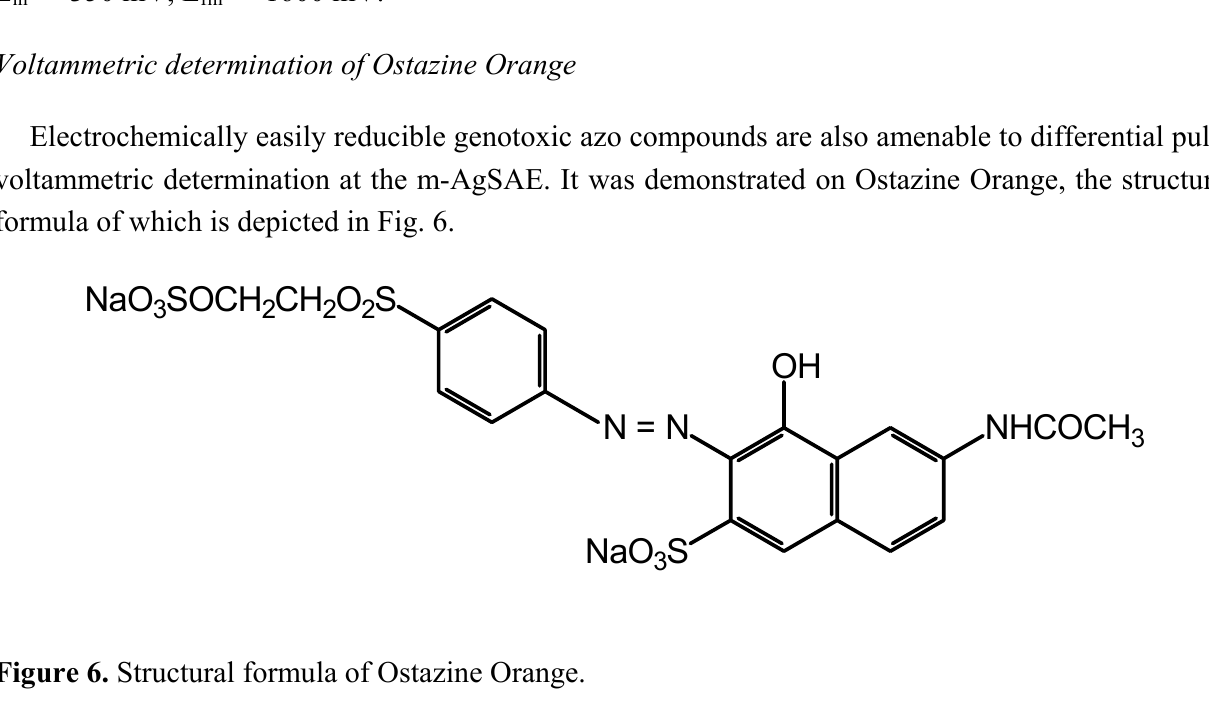
Figure 5. Adsorptive stripping voltammograms of 3-nitrofluoranthene at m-AgSAE in MeOH - - 0.01 mol L -1 NaOH (1:1) mixed medium. c (3-nitrofluoranthene) [µmol L -1 ]: (1) 0 (base electrolyte), = -350 mV; t = 15 s; potentials for regeneration (2) 0.2, (3) 0.4 (4) 0.6, (5) 0.8, (6)1.0. E acc acc E = -350 mV, E = -1600 mV. in fin